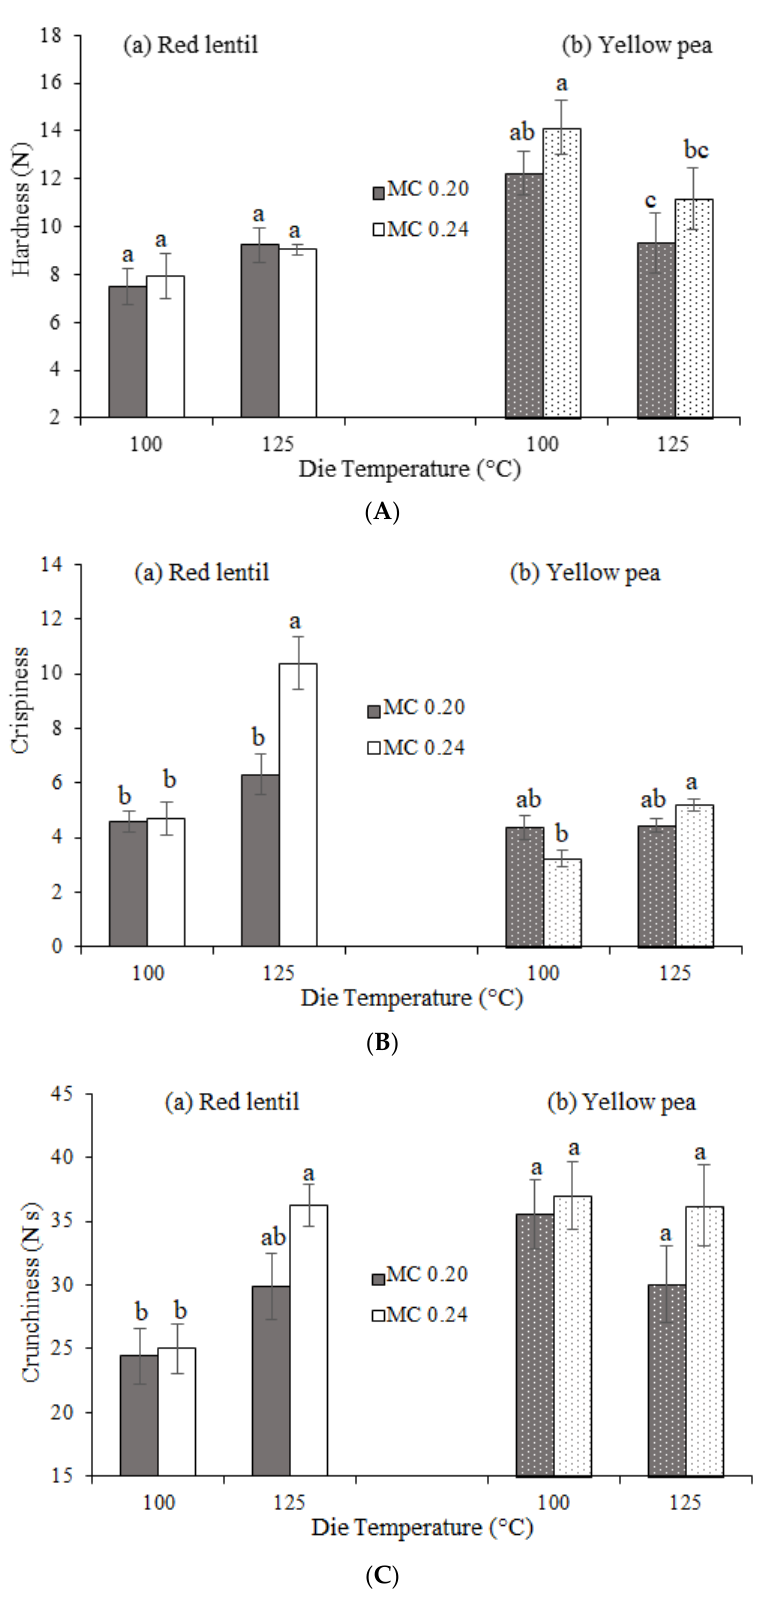
Figure 3. ( A ) Hardness, ( B ) crispiness, and ( C ) crunchiness values of third-generation (a) red lentil and (b) yellow pea products with moisture contents of 0.20 and 0.24 kg water per kg dry flour (MC 0.20 and MC 0.24, respectively). Error bars represent ± standard error. For each flour type, texture parameters designated with different letters are significantly different ( p ≤ 0.05).